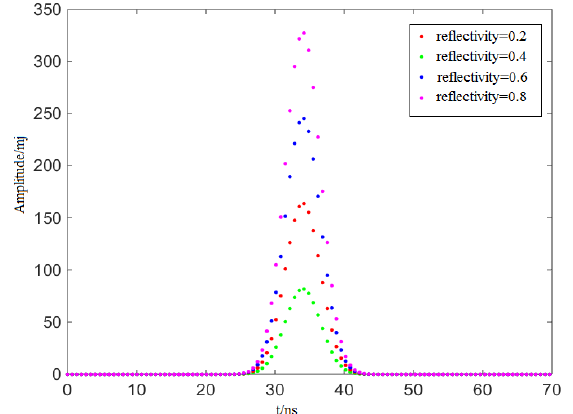
Figure 2. Echo waveforms with different reflectivity.